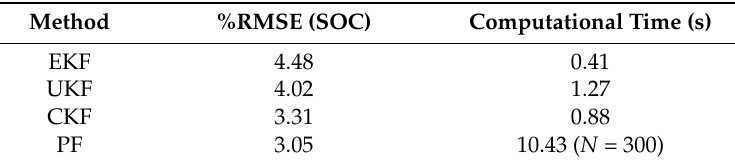
Figure 17. The error in the estimation of SOC. Table 1. Efficiency of the applied state estimation methods [14].